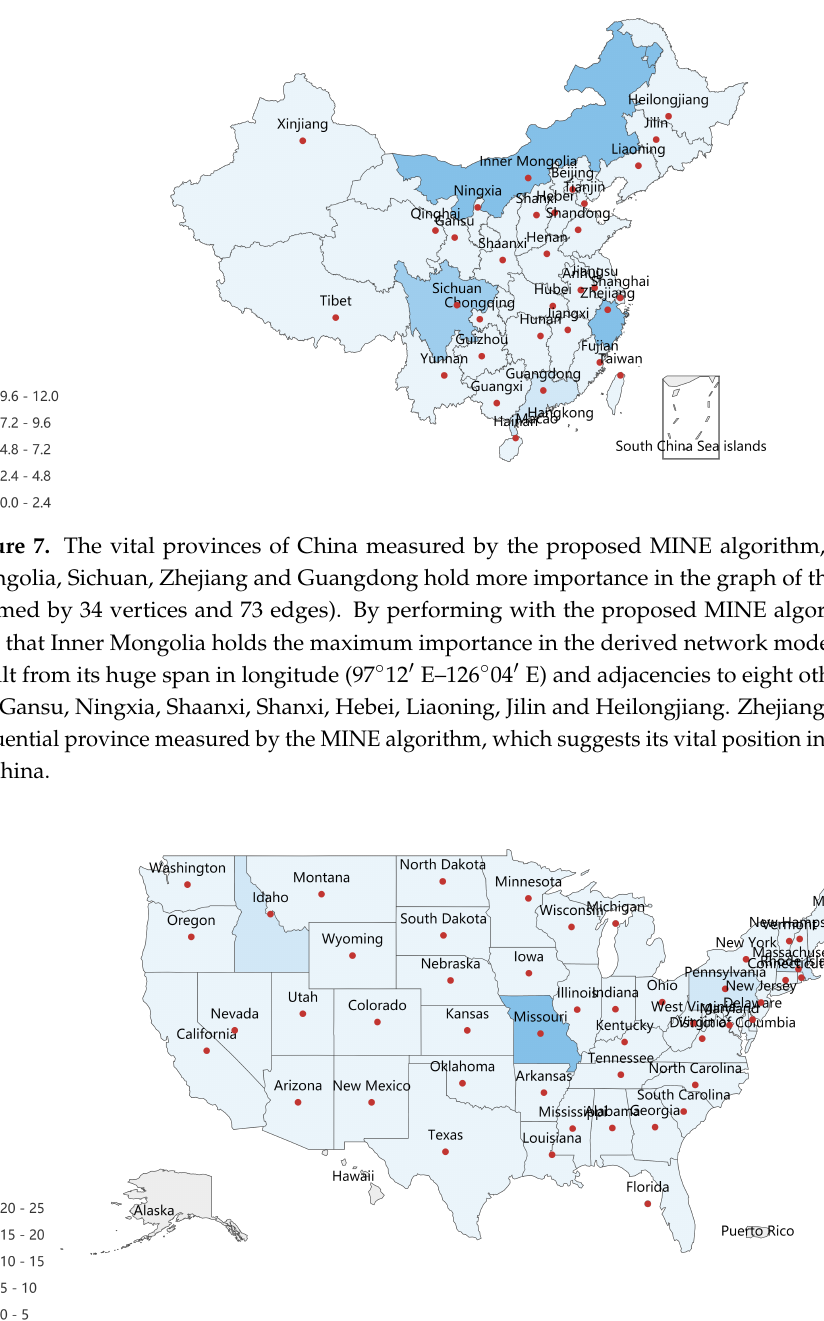
Figure 8. The influence of the lower 48 United States is measured by the proposed MINE algorithm based on the graph of adjacencies (formed by 48 vertices and 104 edges). By performing with MINE algorithm, Missouri (with maximum importance which is same to the conclusion of Meghanathan’s research), following by Massachusetts and Idaho (also pointed out by Meghanathan as a vital state) are identified as the top-3 vital states, which are respectively located in the middle, east and west of the lower 48 United States. By activating the top-3 nodes and their neighbors in the graph of adjacencies, we are able to get a maximum collection of activated states that covers the majority of the United States, which are probably to exert strong